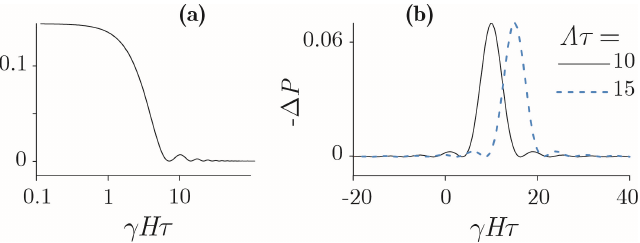
Figure 3. MF dependences of the probability ∆ P of the primary reaction calculated for a stationary ( a ) and rotating ( b ) biophysical